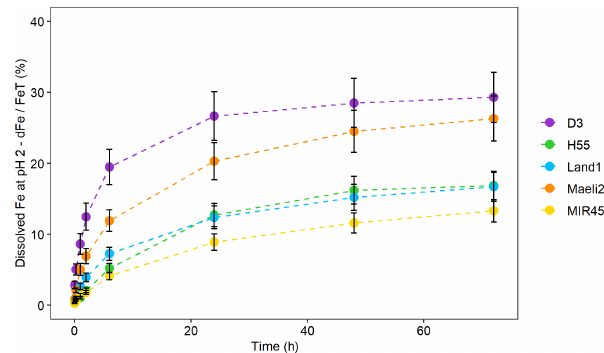
Figure 4. Initial Fe solubility (Fe isol / FeT, %) of Icelandic dust (this study). The data uncertainty was estimated using the error propaga- tion formula. Data for African dust samples (Tibesti and western Sahara) were from Z. B. Shi et al. (2011).